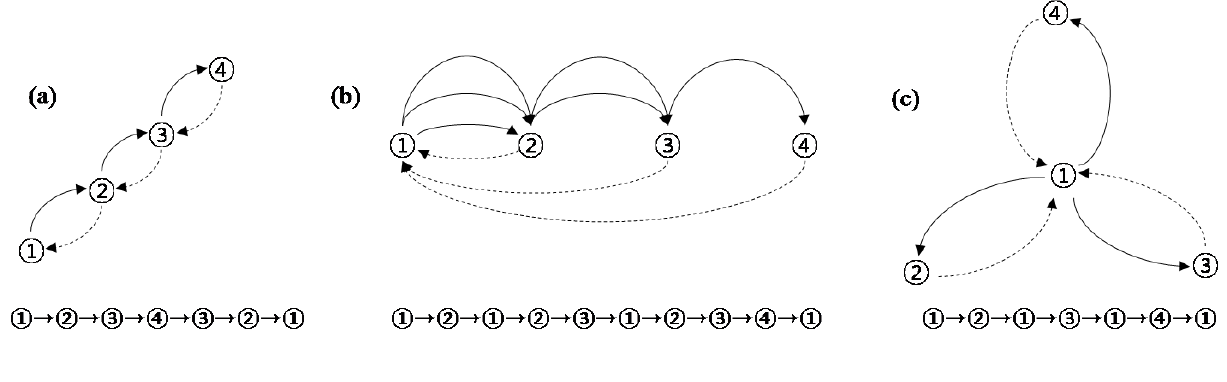
Figure 3. Drift determination methods: ( a ) profile method; ( b ) step method; and ( c ) star method (adapted from